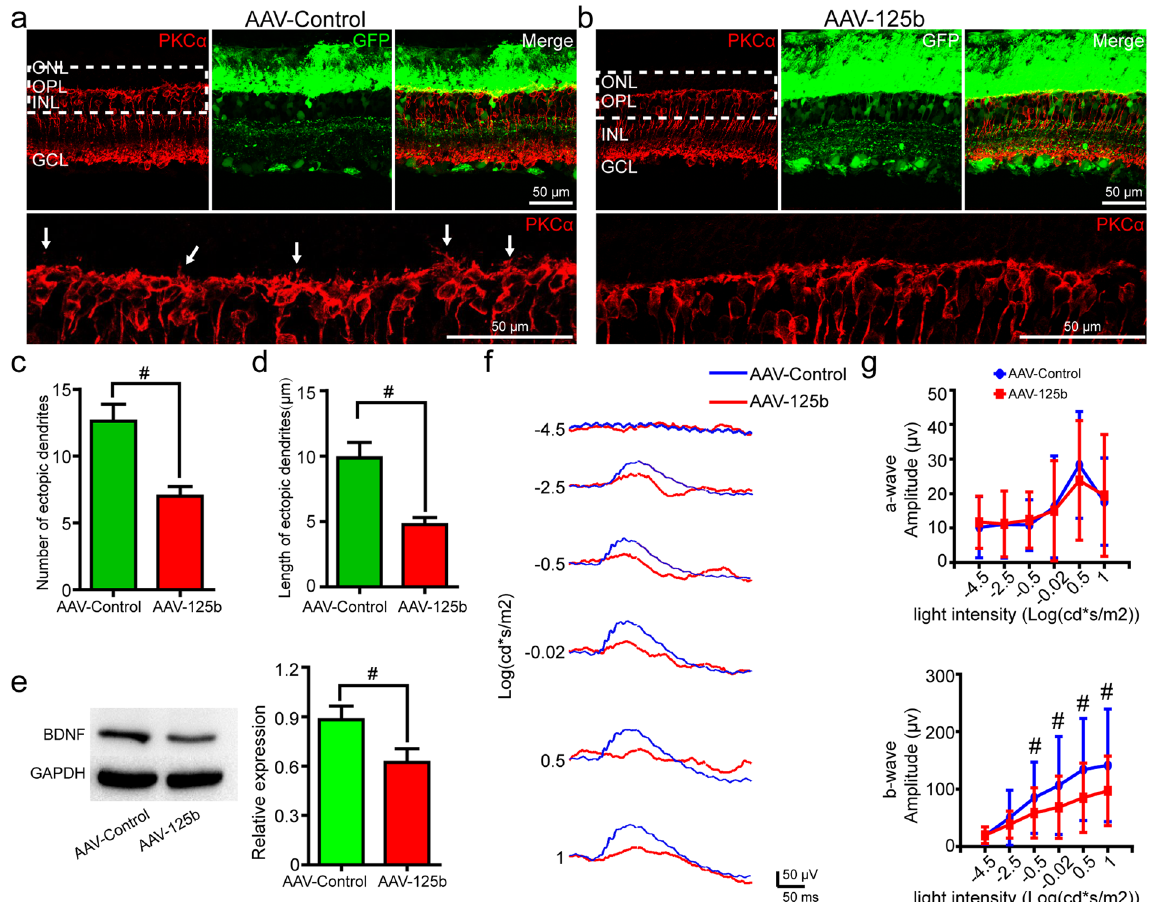
Figure 4. Overexpression of miR-125b-5p decreased the number and length of RBC ectopic dendrites and the ERG responses in RCS rats. Immunostaining of PKC α (red) and GFP (green) in the retinae of P60 RCS rats, five weeks after subretinal injection of ( a ) AAV-control or ( b ) AAV-125b virus. Bottom sub-panel shows magnification of the dotted area in the top left subpanel. Arrows indicate ectopic dendrites. ( c ) Number of RBC ectopic dendrites in RCS rats, five weeks after AAV-Control or AAV-125b treatment, per field view (213 µ m × 213 µ m) (bars show means; error-bars, SEM; n = 5). ( d ) Same for length of ectopic dendrites (n = 5) ( e ) Western blot analysis of BDNF expression in retinae of RCS rats after AAV-Control or AAV-125b treatment, five weeks post-surgery (bars, means; error-bars, SD, n = 4). GAPDH was used as a loading control. For original blot images, please see Supplementary Fig. 12. ( f ) Representative ERG traces in RCS rats, five weeks after subretinal injection of AAV-control or AAV-125b. ( g ) Group data for the amplitude of a-waves (top) and b-waves (bottom) from ERG recordings in RCS rats, five weeks after surgery (bars, means; error-bars, SD; n = 13). ONL: outer nuclear layer; OPL: outer plexiform layer; INL: inner nuclear layer; GCL: ganglion cell layer. * p < 0.05; # p <